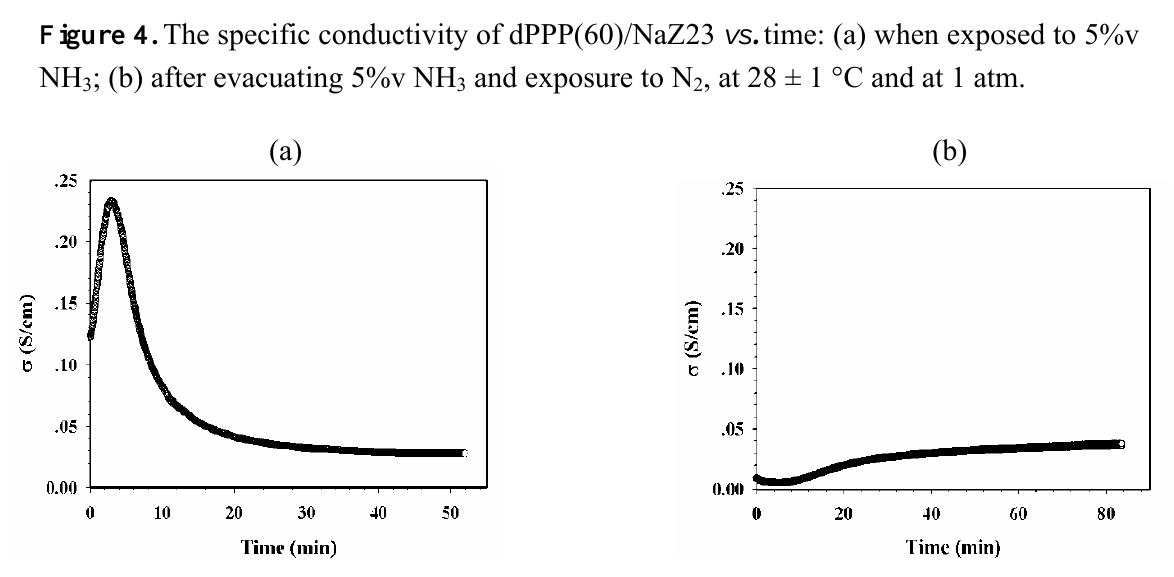
Figure 4. The specific conductivity of dPPP(60)/NaZ23 vs. time: (a) when exposed to 5%v